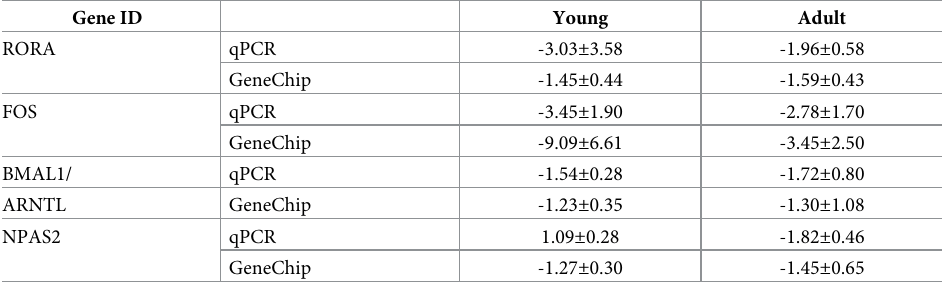
Table 2. qPCR validation of specific circadian related genes at 3 months of disease progression.